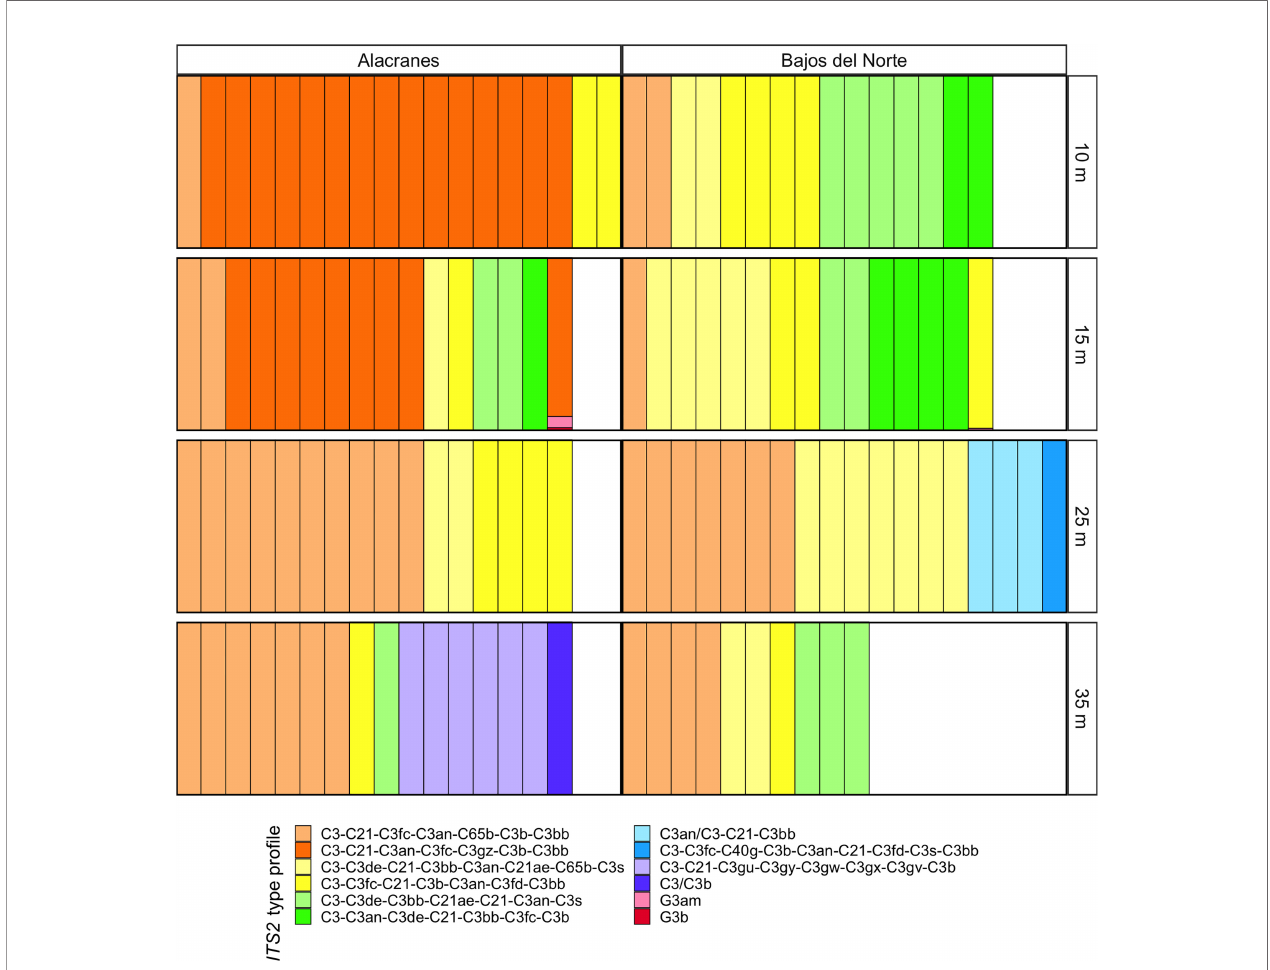
FIGURE 5 | The relative proportion of ITS2 type pro fi les of the Symbiodiniaceae communities hosted by the Montastraea cavernosa coral samples across the four depth zones and two reefs. ITS2 type pro fi les are listed in order of overall abundance. ITS2 type pro fi les are named for the de fi ning intragenomic variants (DIVs) used to characterize them. DIVs in a type pro fi le name are listed in order of abundance with slashes separating DIVs that are co-dominant across